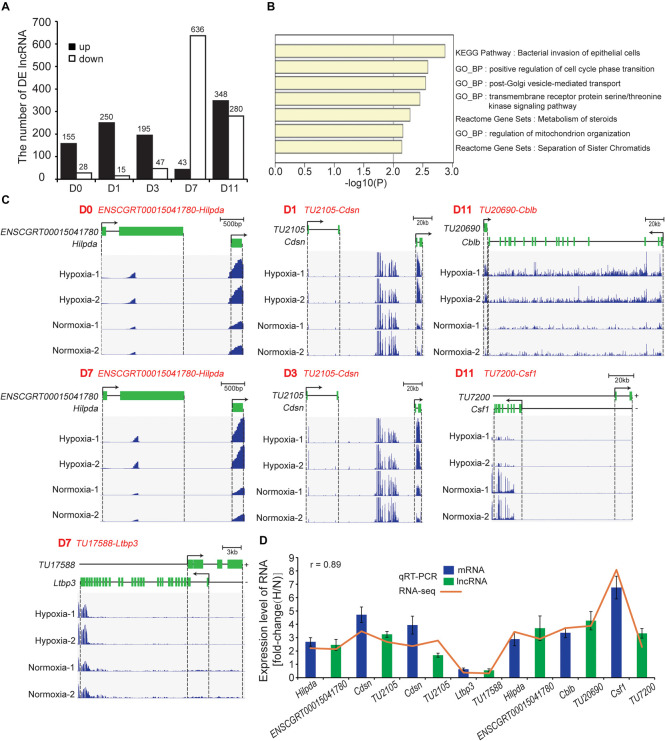
Identification and functional analysis of DE mRNAs. (A) Number of DE lncRNAs at the five timepoints of adipogenesis. (B) Functional enrichment analysis of combined DE mRNAs that were highly correlated and simultaneously locus-nearby with DE lncRNAs. (C) Loci and expression levels of lncRNA and mRNA. ENSCGRT00015041780-Hilpda (D0 and D7), TU2105-Cdsn (D1 and D3), TU17588-Ltbp3 (D7), TU20690-Cblb (D11), and TU7200-Csf1 (D11), respectively. (D) Seven lncRNA-mRNA pairs were selected to validate RNA-seq results using qRT-PCR. H, hypoxia; N, normoxia.